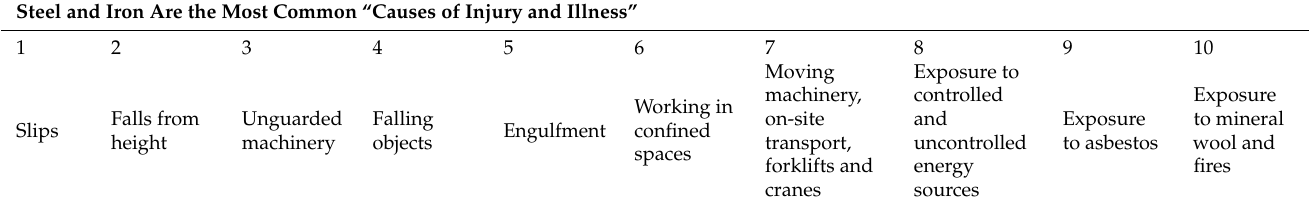
Table 4. Most common threats to health in steel and iron industry (based on ILO [176] code of practice on safety and